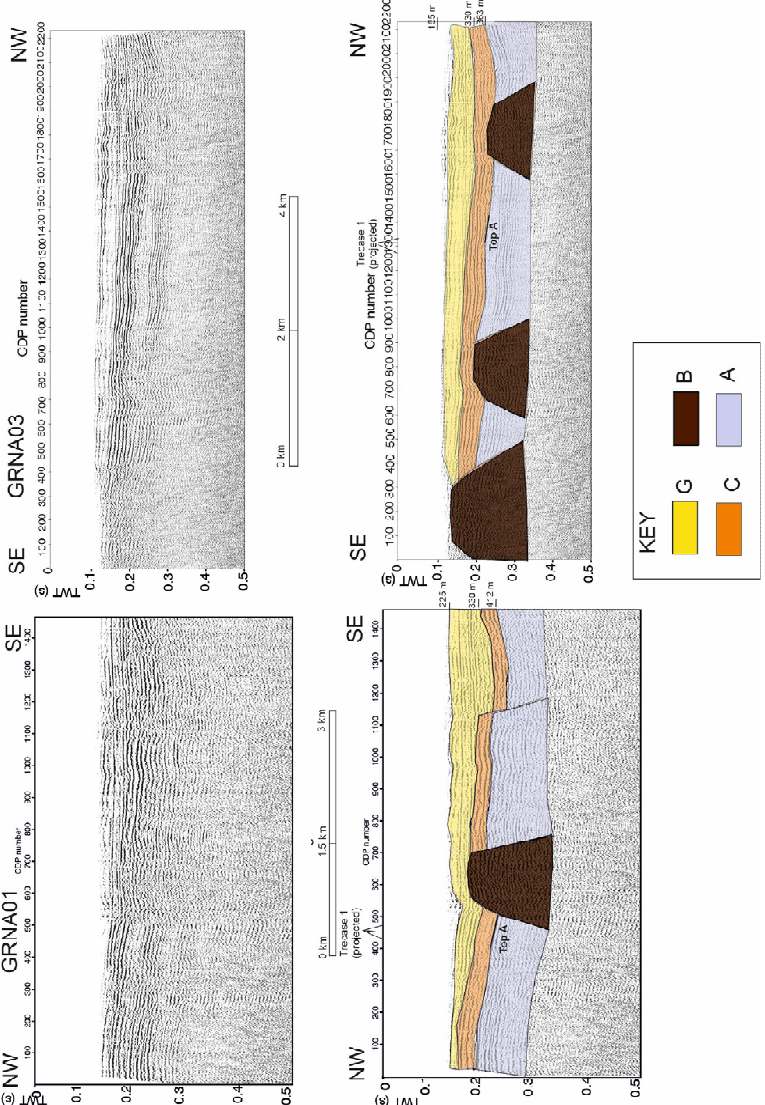
Figure 6. Seismic profile Grna01 (left side) and seismic profile Grna03 (right side), and corresponding geologic interpretation calibrated with the “Trecase 1” well (Figure 2).